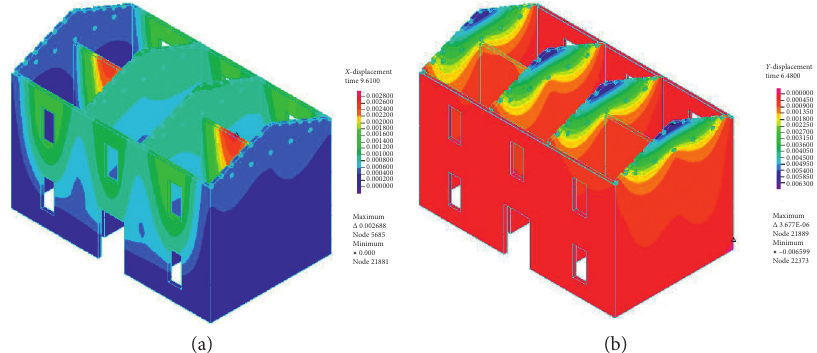
Figure 8: Cloud diagram of wall peak displacement under Taft earthquake with 7-degree fortification intensity. (a) X -direction. (b) Y -direction.